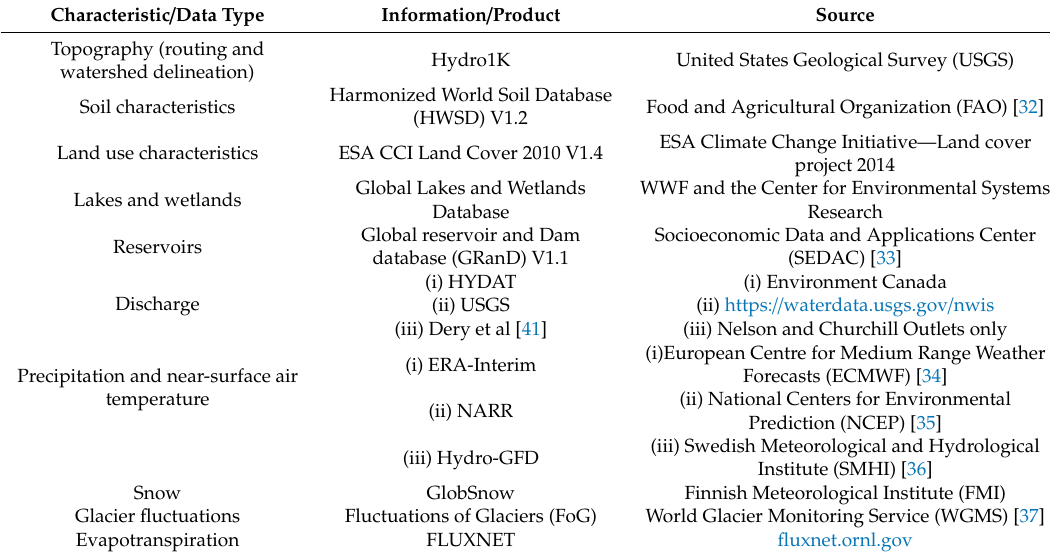
Table 1. Type of Data used for Hydrological modeling in Hydrological Predictions for the Environment (HYPE) and their